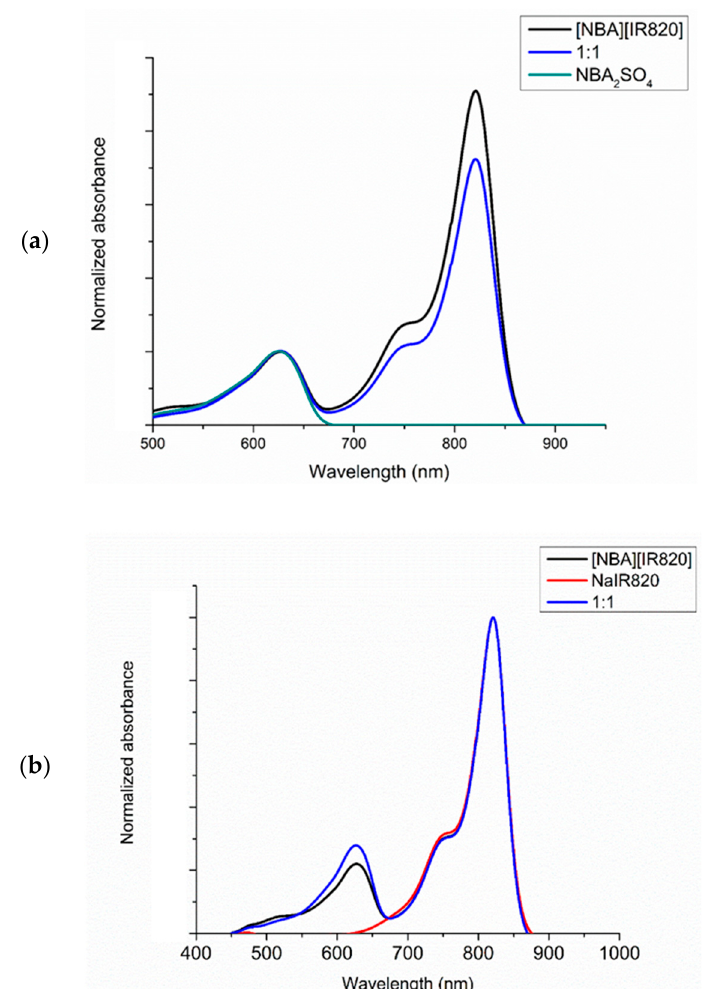
Figure 2. Absorption spectra normalized ( a ) at 629 nm and ( b ) at 820 nm in ethanol. The fluorescence emission spectra of NBA 2 SO 4 , NaIR820, the mixture, and [NBA][IR820] IM are recorded in ethanol at two different excitation wavelengths, i.e., 629 nm and 820 nm. All the normalized fluorescence emission spectra with respect to parent NBA 2 SO 4 are presented in Figure 3.